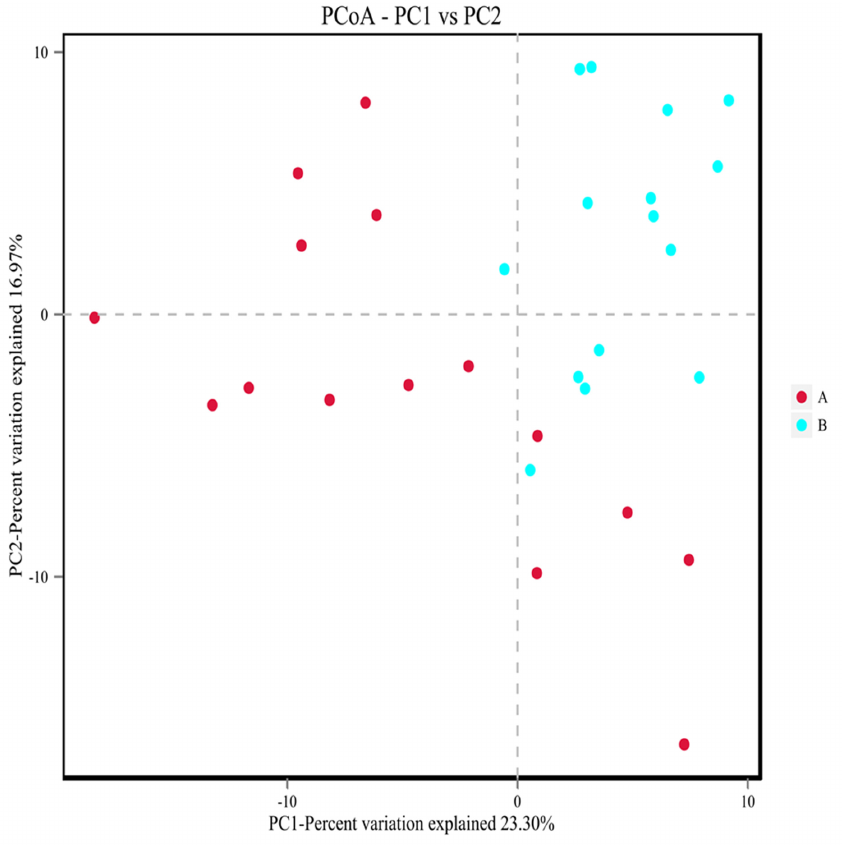
20 Figure 20. Rank abundance curve of each sample for each group. The abscissa represented the OTU level, and the ordinate represented the relative abundance. Each sample was marked with different color curves.